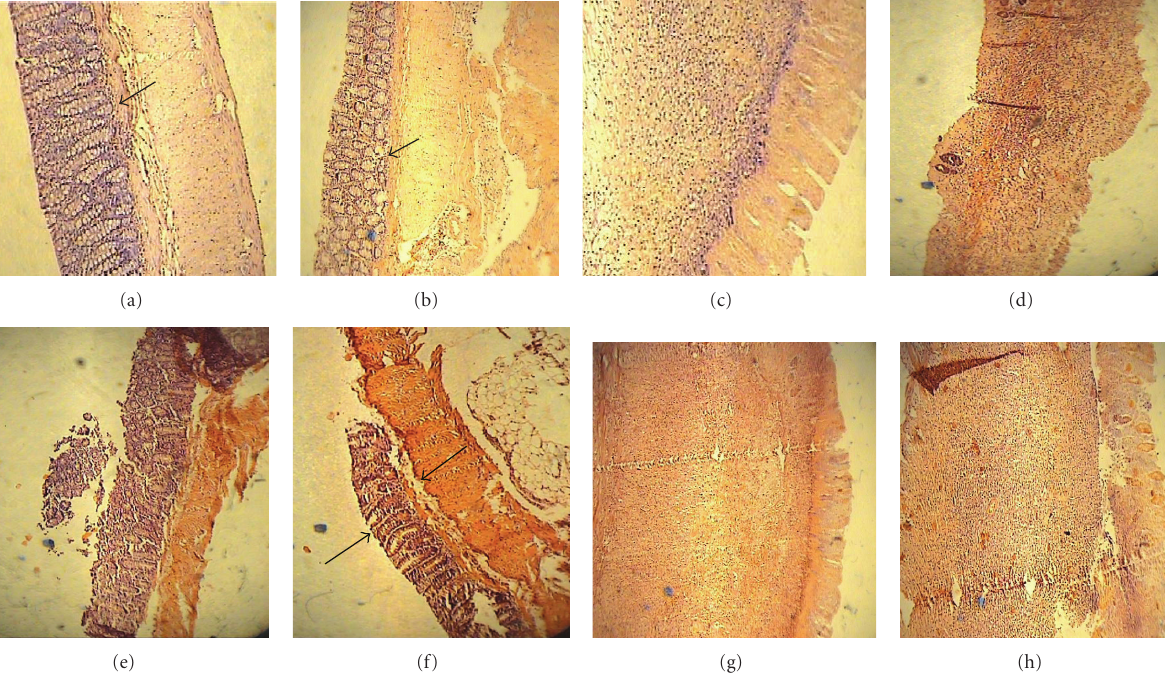
Figure 3: Microscopic presentation of TNBS-induced colitis in rats (hematoxylin and eosin staining; original magnification × 10). (a and b) Normal groups: mucus layer and crypts are normal; (c and d) TNBS-control groups: epithelial distortion, crypt damage, and inflammatory cell infiltrates; (e and f) dexamethasone (i.p and p.o, resp.): moderate mucosal and submucosal inflammation and mucosal inflammatory cell infiltrates; (g and h): cisapride (i.p and p.o, resp.) infiltration of neutrophils and destruction of mucosal